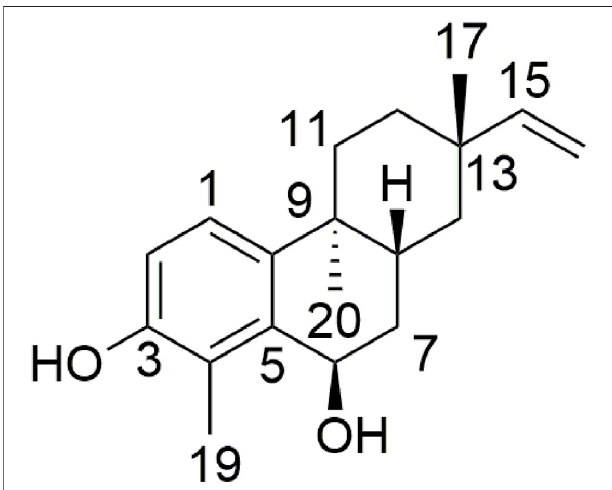
FIGURE 1 | Structure of compound 1 isolated from E. nematocypha .